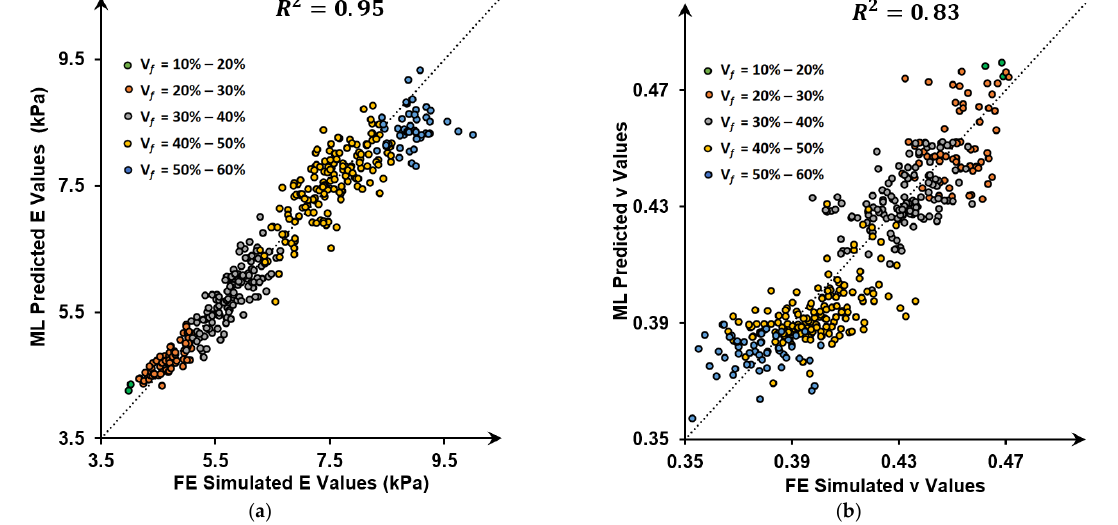
Figure 4. ( a ) The Young ’ s modulus and ( b ) Poisson ’ s ratio predicted by the CNN are plotted and compared to those obtained from FE simulation.